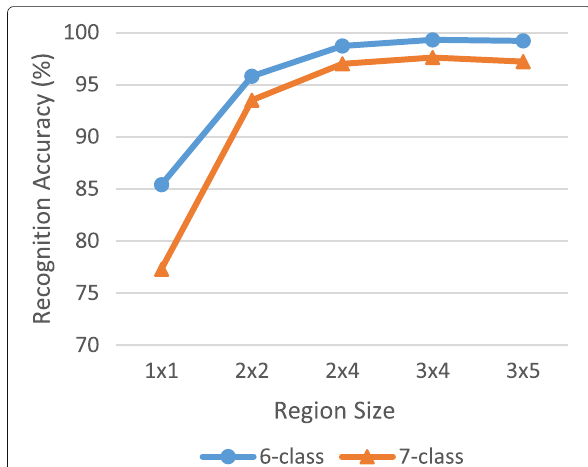
Fig. 10 The effect of varying component region size on recognition accuracy in CK+ dataset